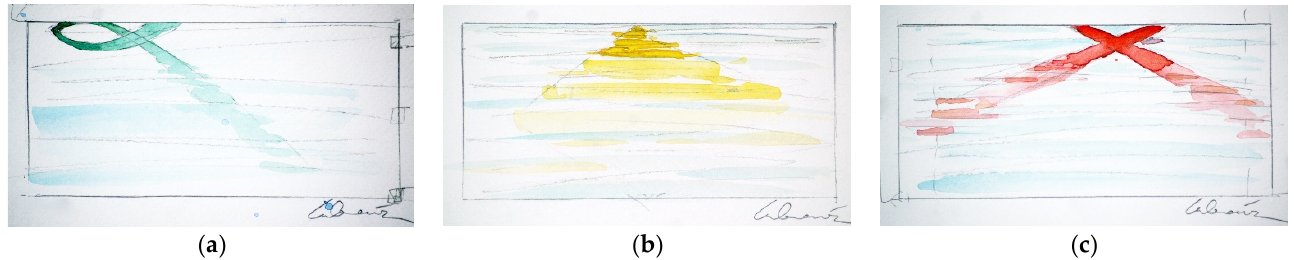
Figure 18. Glass-art designs by Tomasz Urbanowicz for the Faculty of Theology of the University of Silesia in Katowice, Poland, 2004: ( a ) watercolor with the green ichthus theme; ( b ) watercolor with the yellow Holy Trinity theme; ( c ) watercolor with the red cross theme (Tomasz Urbanowicz).